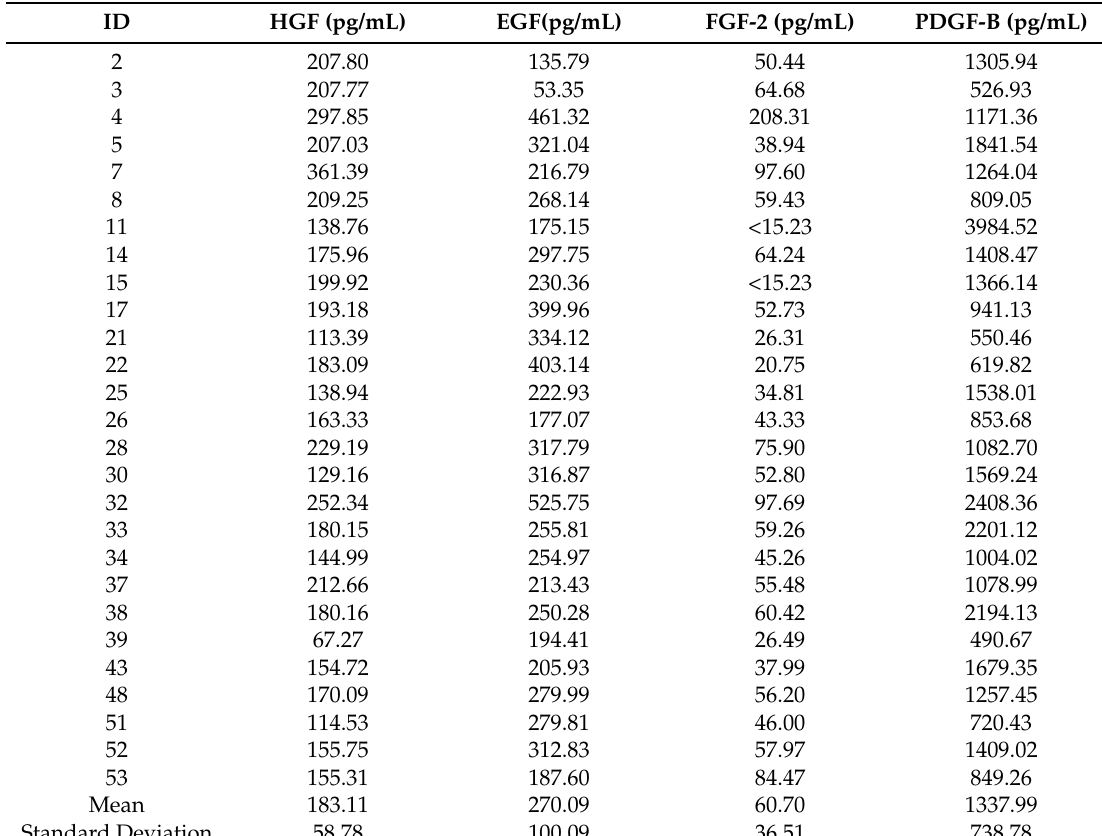
Table 4. Growth Factor concentration in defrosted